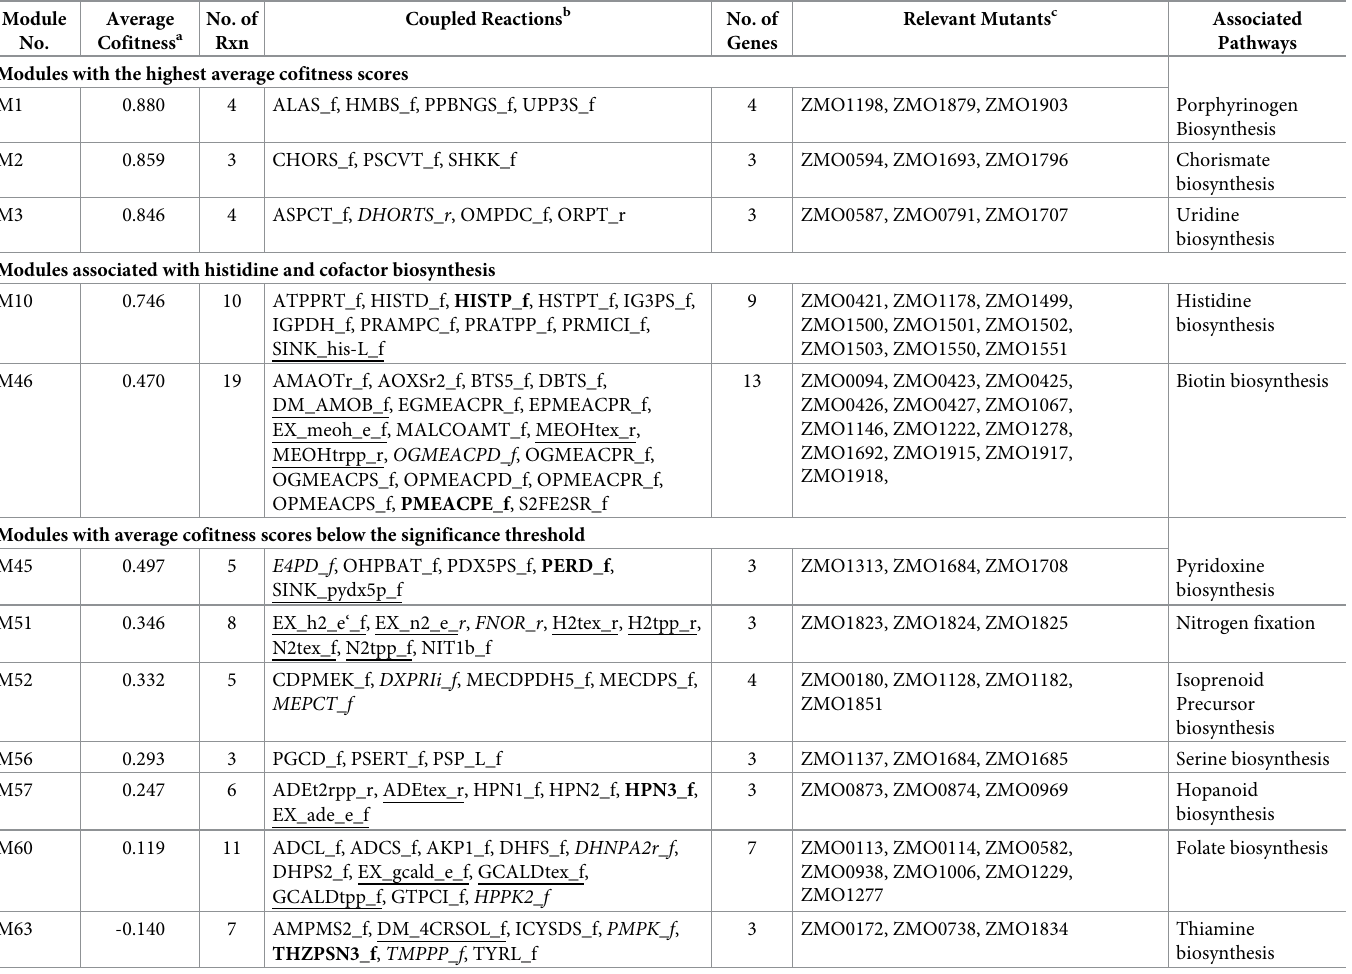
Table 3. Cofitness scores of select metabolic modules. Module